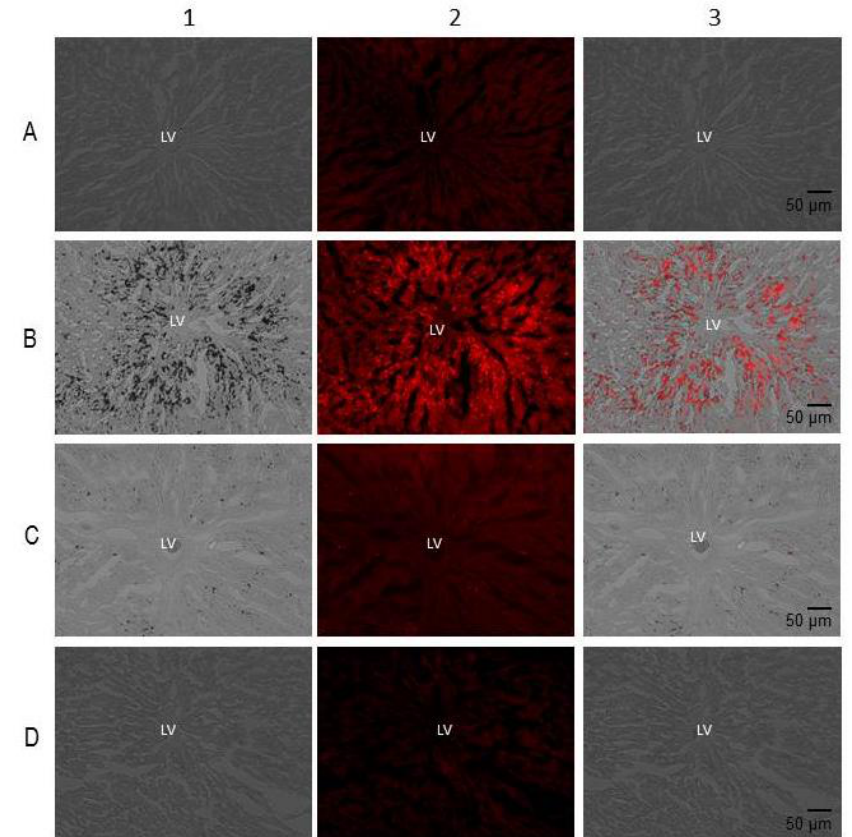
Figure 1. Representative micrographs of oily red staining in rat liver slices. The images were obtained using transmitted light. Abbreviations: MS = Metabolic syndrome, C = Control, RSV + QRC = resveratrol plus quercetin. Panel A= MS plus RSV + QRC, Panel B= MS, Panel C = C, Panel D = C plus RSV + QRC, LV = liver vein. Vertical line 1 = relief phase, vertical line 2 = red fluorescence channels merge and vertical line 3 = upper right end on the FLoid ® Cell Imaging Station.